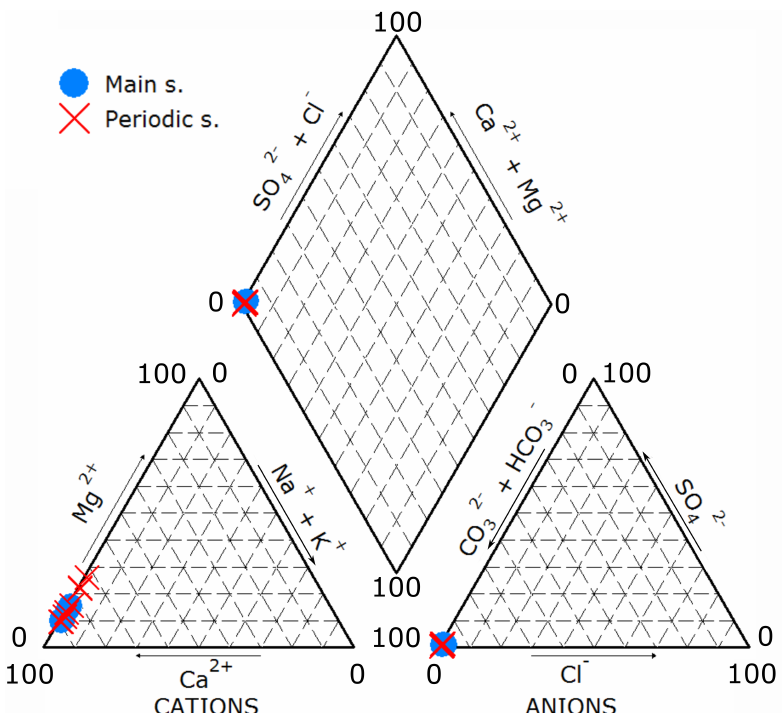
Figure 5. Piper diagram of the springs